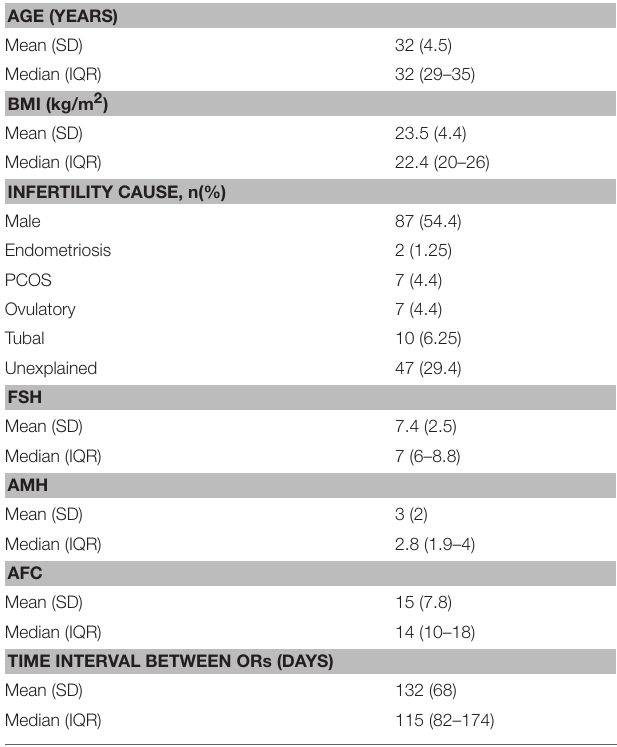
TABLE 1 | Baseline characteristics of suboptimal